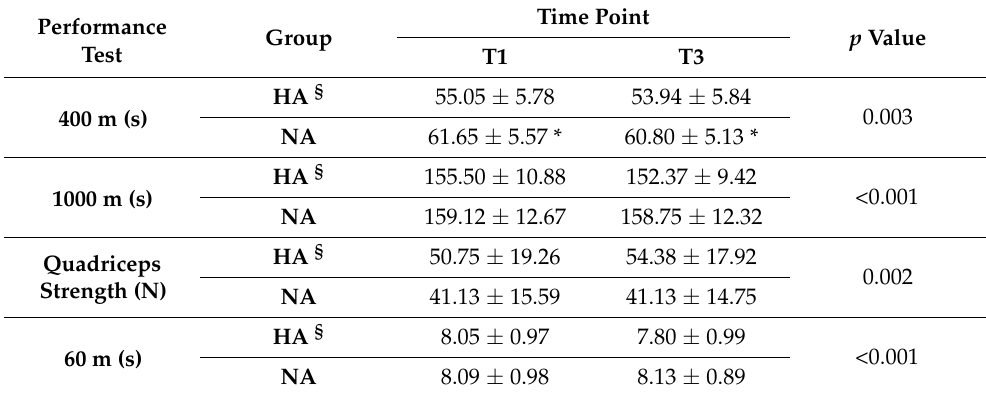
Table 8. The performance test results of the athletes in the two study groups at T1 and